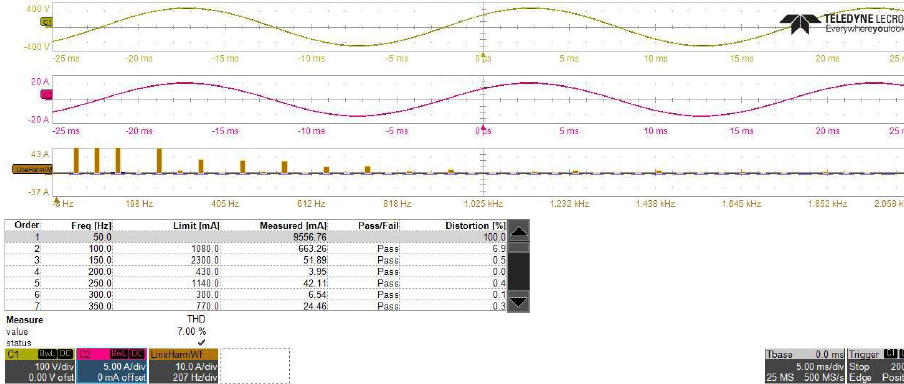
Figure 37. Harmonic measurement of system.